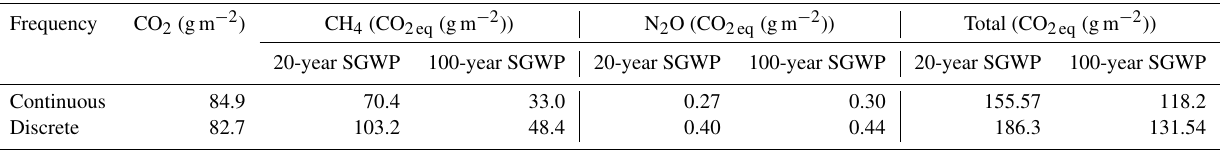
Table 2. Sustained global warming potential (SGWP) derived from continuous (over ∼ 72h) and discrete (1 h before and 1 h after daytime low tide) temporal measurements in a tidal salt marsh.